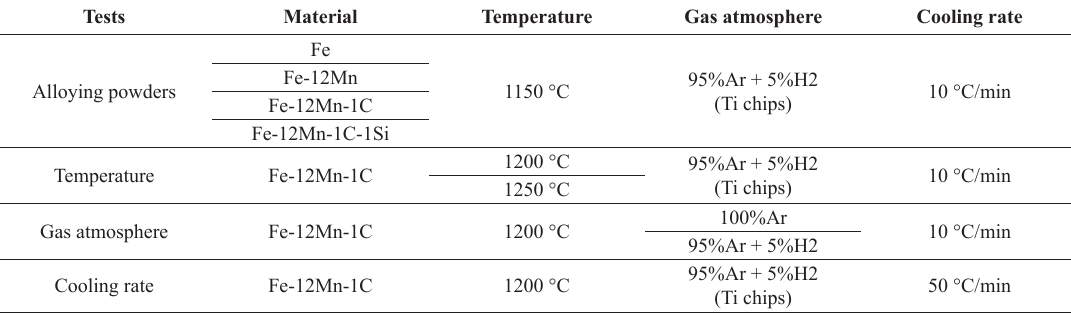
Table 2. List of tests carried out to understand the effect of alloying powders, sintering temperature, gas atmosphere and cooling rate. Tests Material Temperature